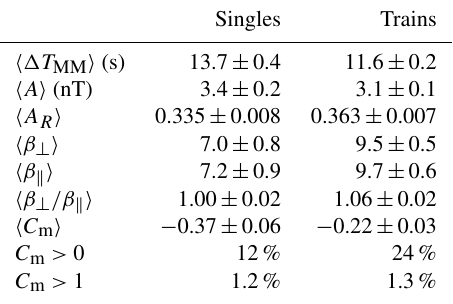
Table 4. Average properties of both individual MMs and the ones in MM trains and their plasma properties. The errors are defined by SE. The relative amount of plasma that is above the mirror instabil- ity threshold ( C m = 0) and that exceeds C m = 1 in the surroundings of both types of MM are given.